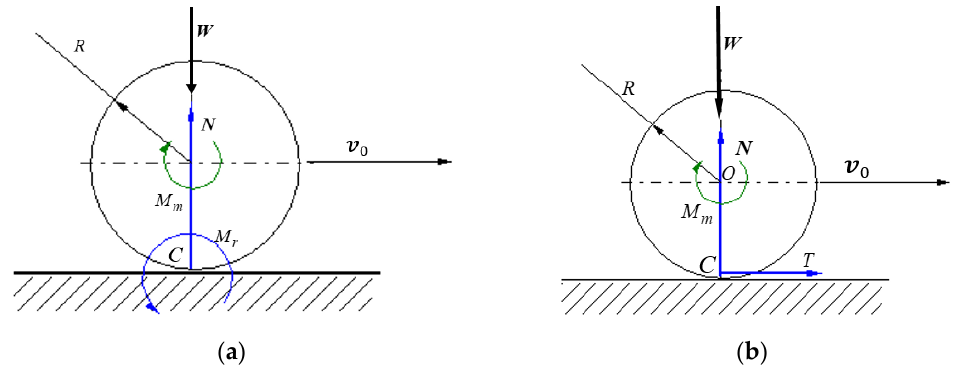
Figure 3. Characterization of rolling friction by means of ( a ) the rolling friction torque; ( b ) the friction force.